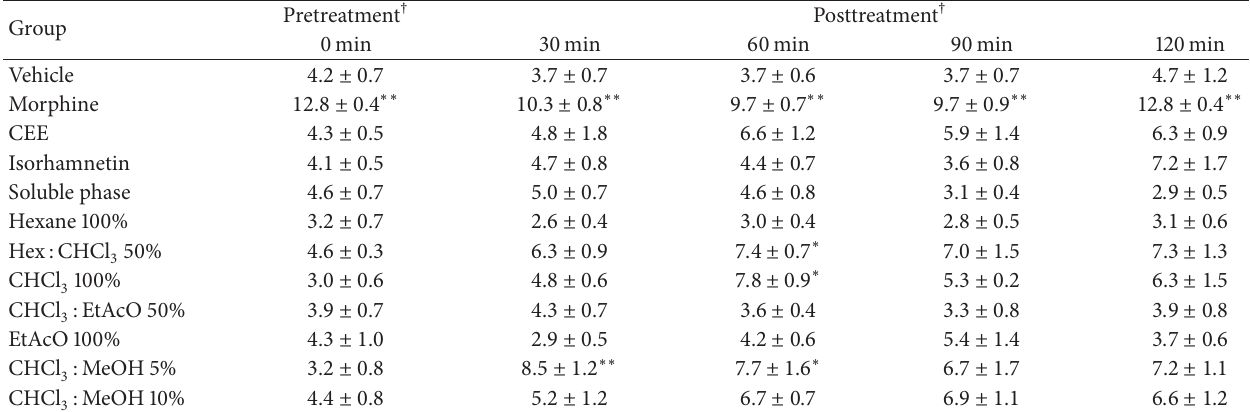
Table 1: Effect of extract, fractions, and isorhamnetin in the hot plate test. Group